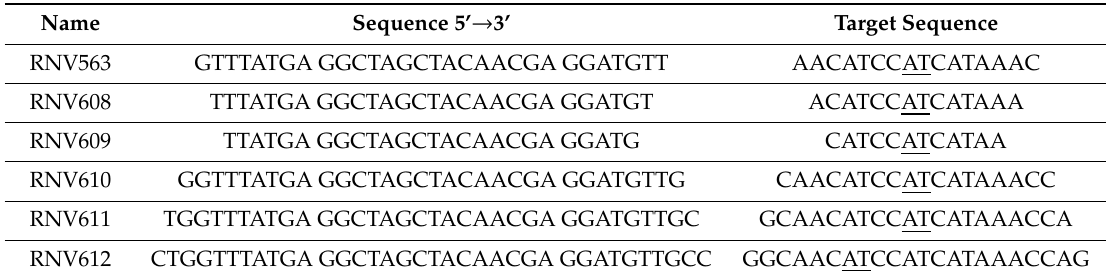
Table 1. Second-generation DNAzymes derived from the first-generation parent DNAzyme RNV563, their sequences, and their target